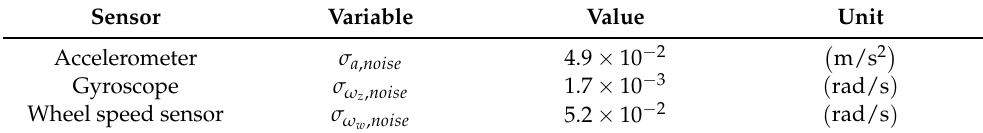
Table 2. Sensor noise